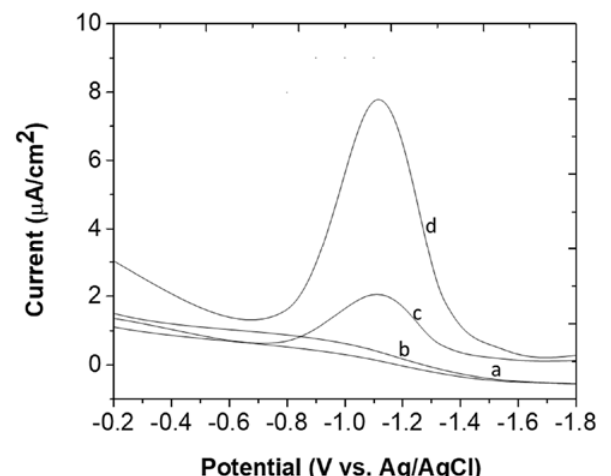
Fig. 6. Differential pulse voltammograms for 6.0 µg ⸳ mL -1 butachlor at bare GCE (a), MWCNTs/GCE (b), Pd/GCE (c) and Pd@ MWCNTs/GCE (d) in pH 6.0 (0.10 M of phosphate buffer); accumulation potential –1.13 V; accumulation time 80 s; pulse amplitude 30 mV; scan rate 50 mV s -1 .